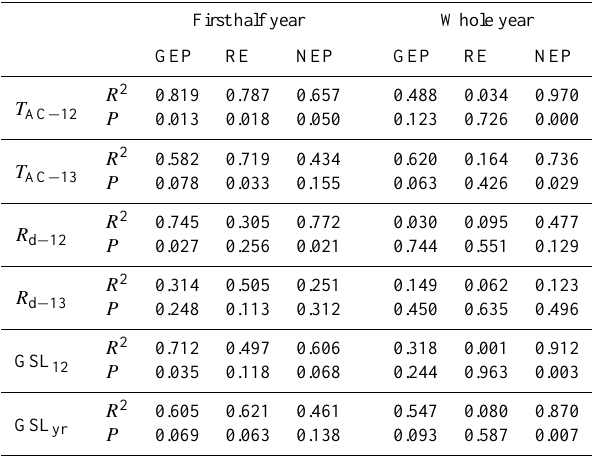
Table 4. The relationships of CO 2 fluxes with accumulative air tem- perature, solar radiation and growing season length during 2003–